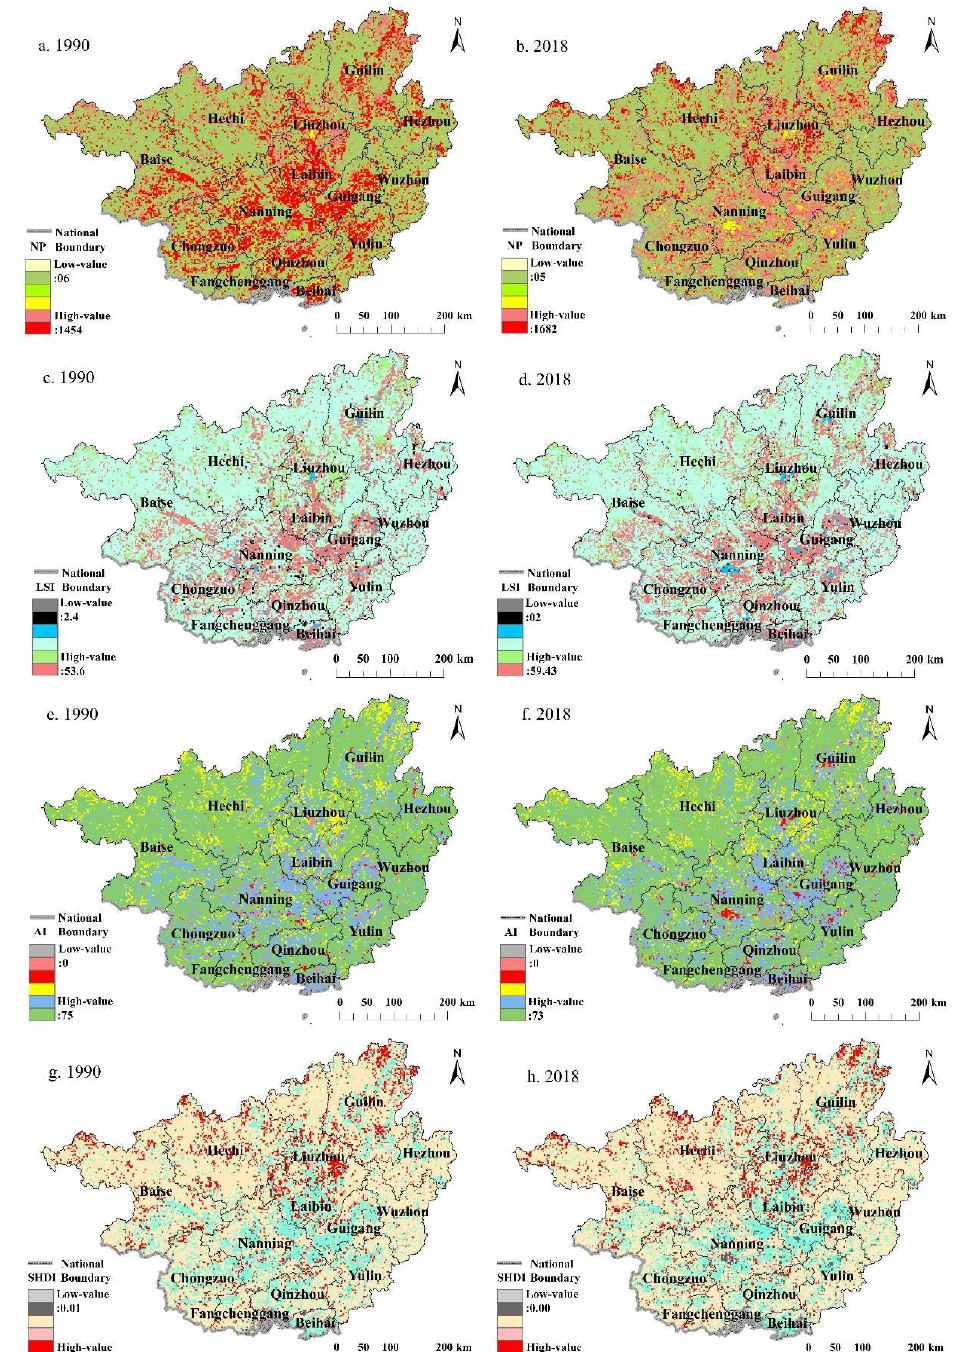
Figure 4. Spatio-temporal distribution of NP, LSI, AI, SHDI at the landscape scale level in Guangxi.